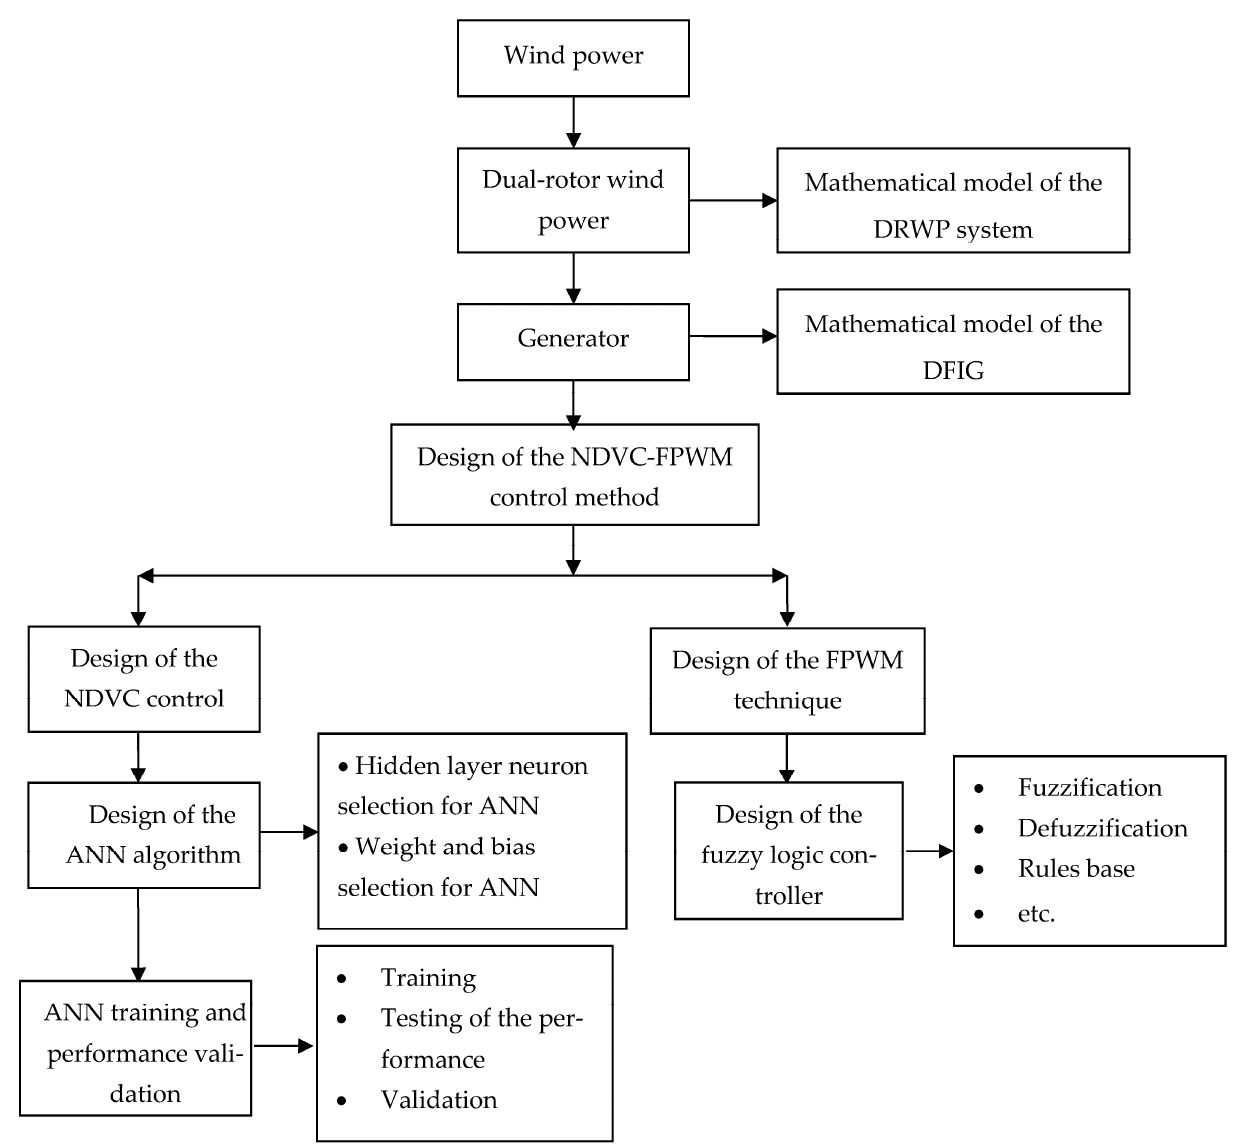
Figure 1. Diagram of research steps followed in this paper.